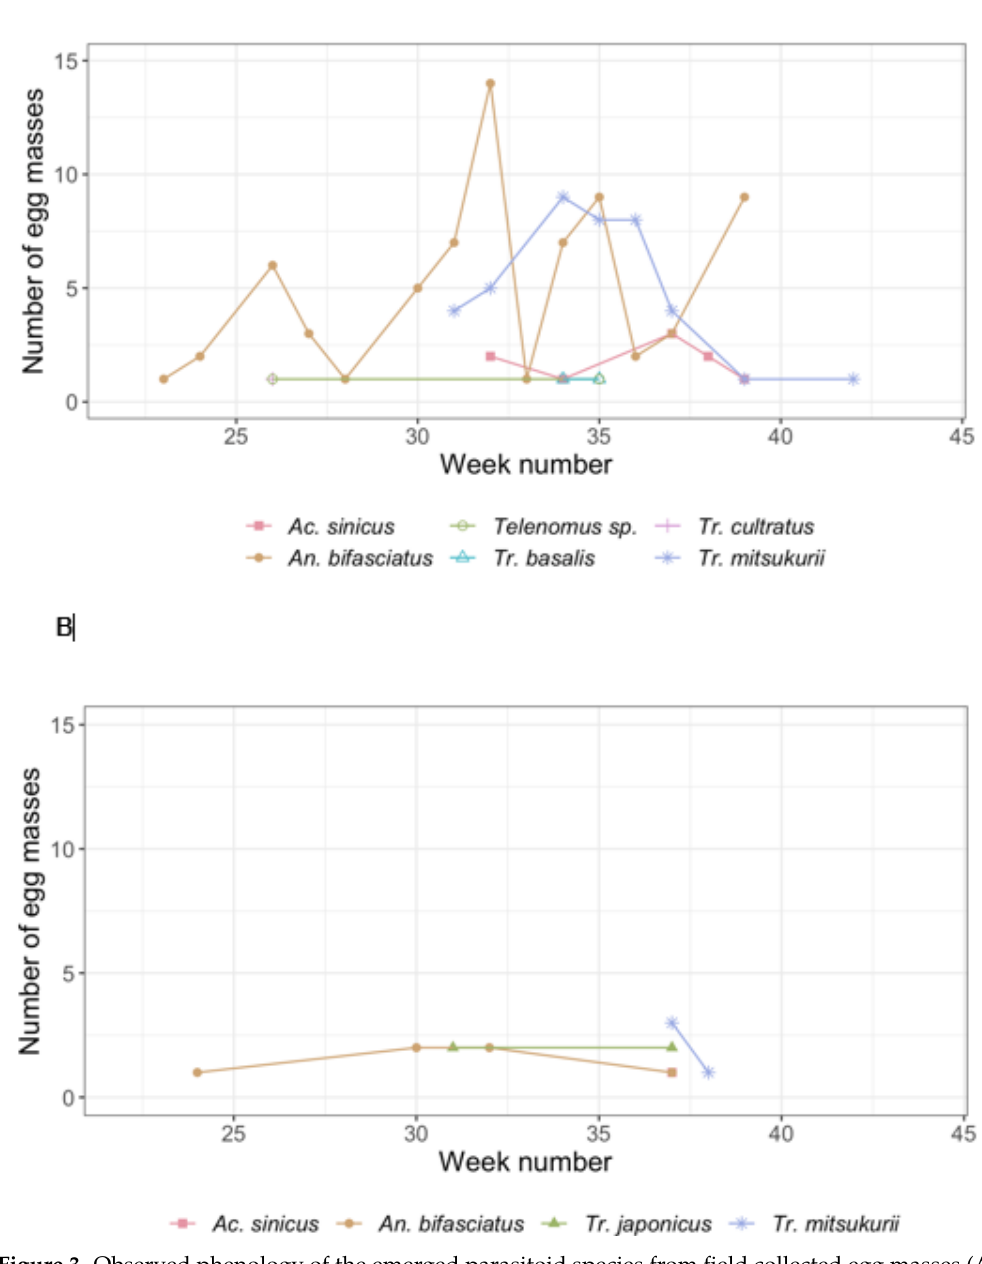
Figure 3. Observed phenology of the emerged parasitoid species from field collected egg masses ( A ) and sentinel egg masses ( B ).